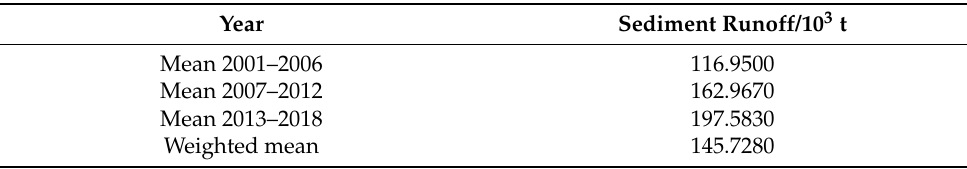
Table 3. Annual sediment transport of the Tarim